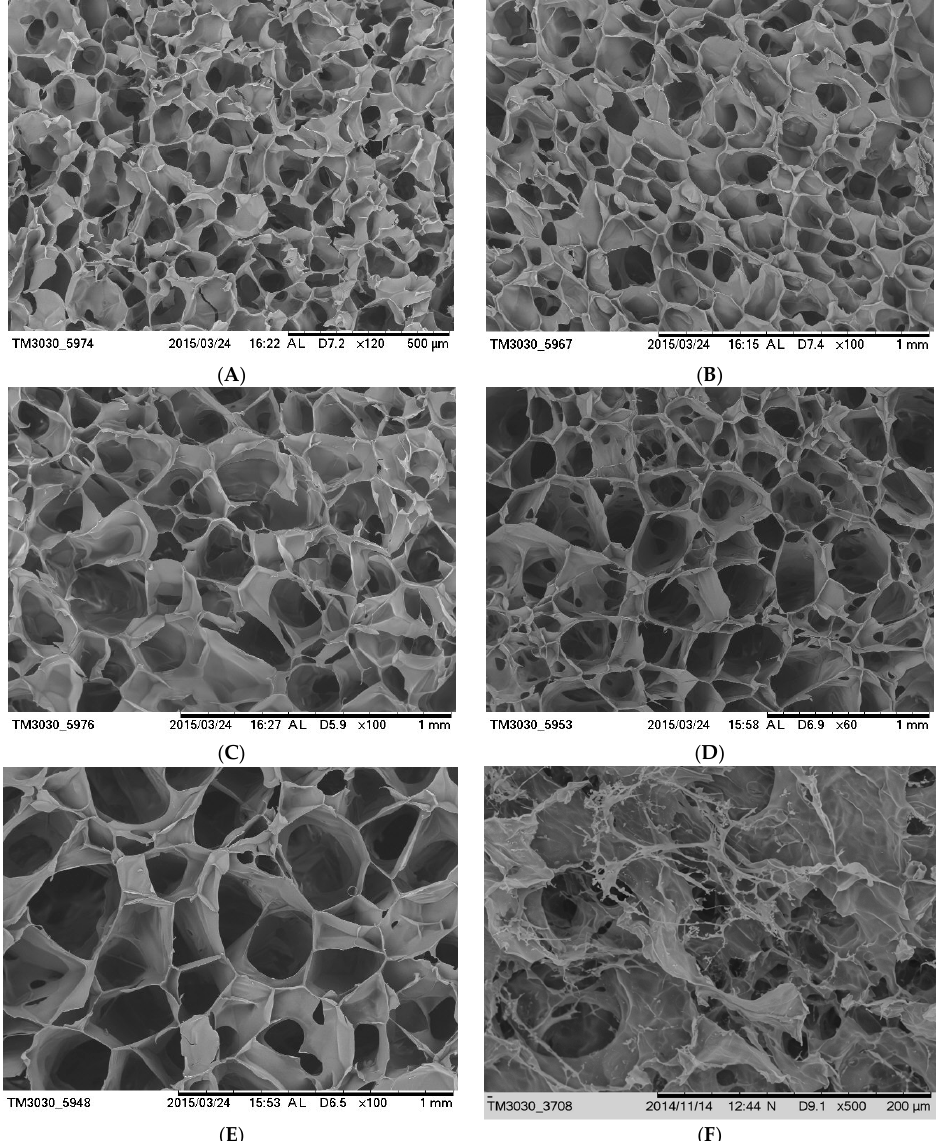
Figure 1. SEM images of cross-section morphology with different ratios of SF/NVP: ( A ) 90/10, ( B ) 80/20, ( C ) 70/30, ( D ) 60/40, ( E ) 50/50 and ( F ) pure SF hydrogel.